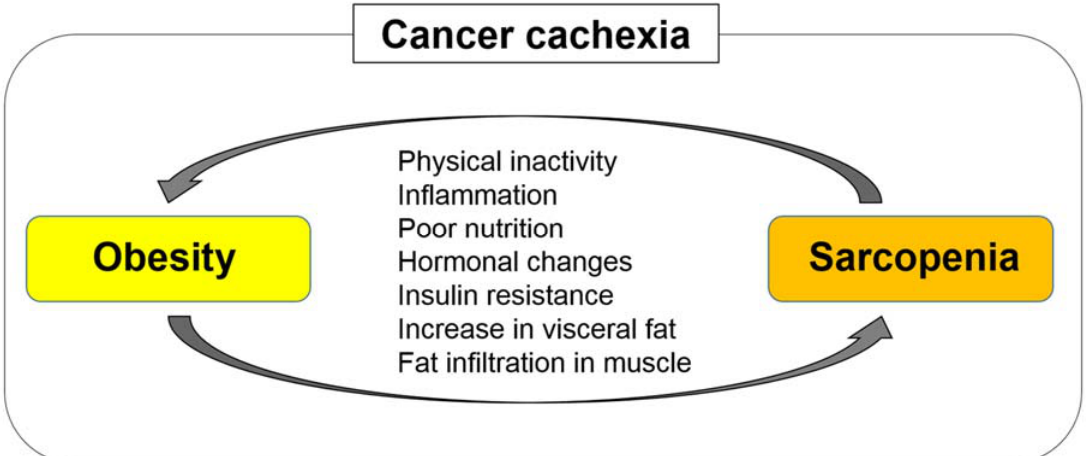
Figure 3. Sarcopenia and obesity can interplay and exacerbate each other. Sarcopenia and obesity have common etiologies, including physical inactivity, inflammation, poor nutrition, hormonal changes, and insulin resistance. Obesity can facilitate skeletal muscle depletion and fat infiltration in skeletal muscle tissues through increased secretion of inflammatory cytokines and increased insulin resistance, leading to poor physical function and performance. Meanwhile, sarcopenia impairs physical activity and function, increasing visceral fat and worsening obesity.